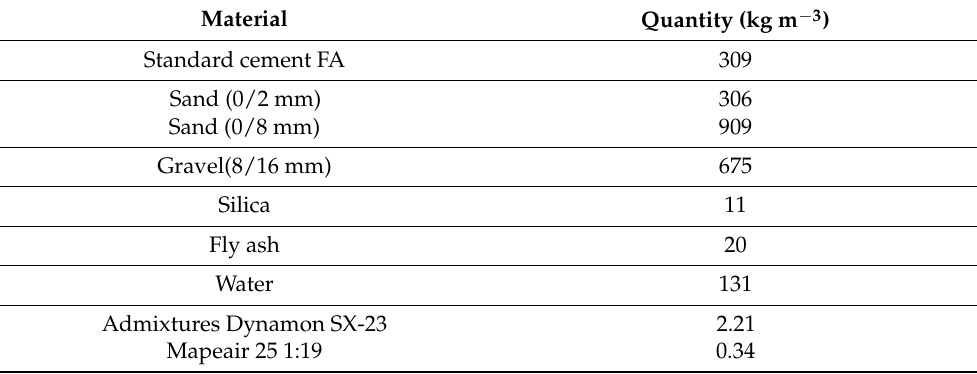
Figure 1 . Geometry and steel reinforcement of the beams Table 1. Composition of the concrete mixture in one cubic meter. Table 1. Composition of the concrete mixture in one cubic meter.